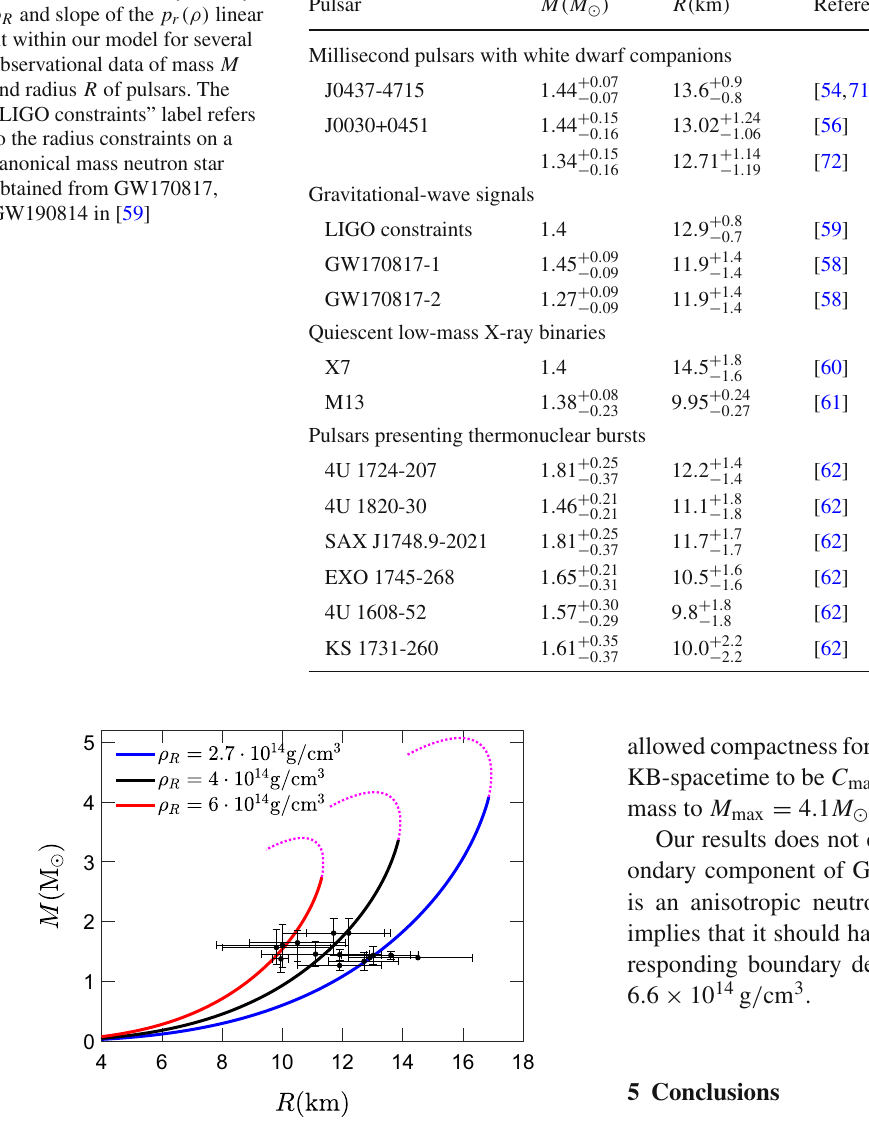
Fig. 7 The mass–radius curve for three different boundary conditions